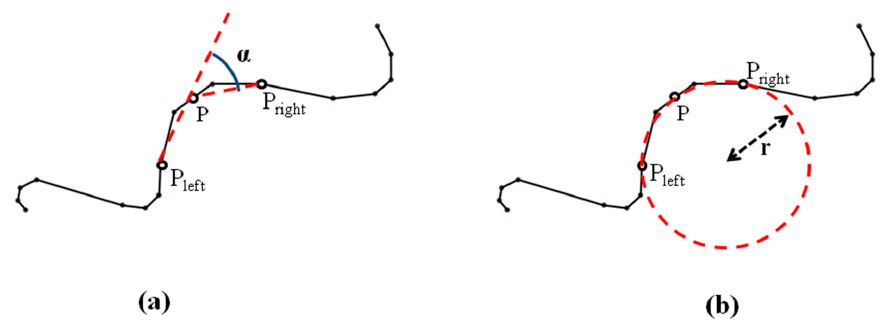
Figure 1. Curvature derivation through ( a ) using a tangent vector or ( b ) fitting a circle [5].